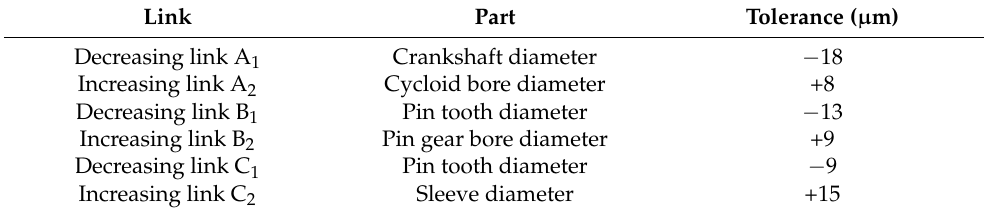
Table 3. Assembly dimensional